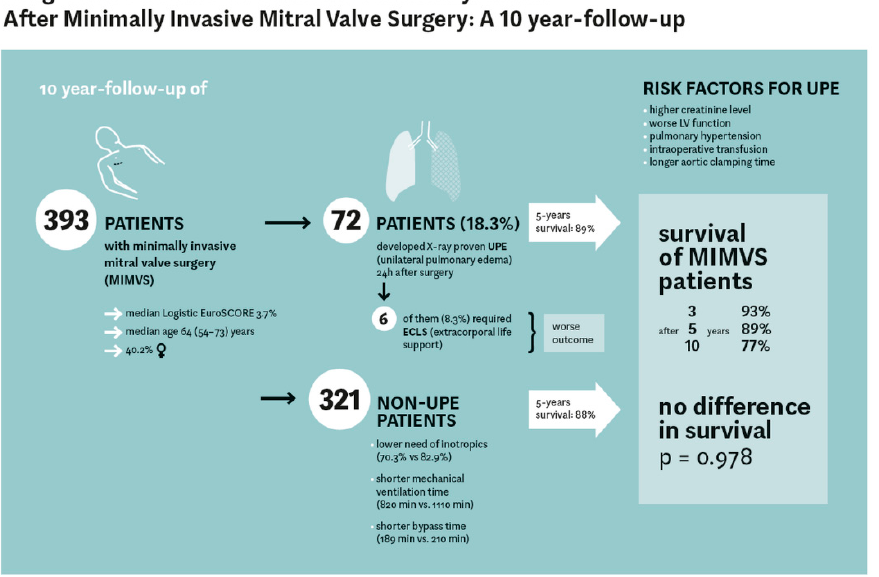
Figure 6. shematic overview of the study: Long-term outcomes of unilateral pulmonary edema after minimally invasive mitral 325 valve surgery: a 10-year follow-up.